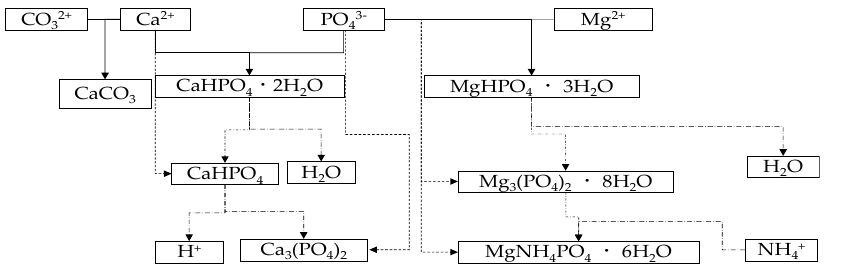
Figure 1. Reaction map of calcium and magnesium with soluble phosphate ( − : primary solid crystallization; − · − : transform to a secondary solid; − − − : precipitate of the secondary solid).